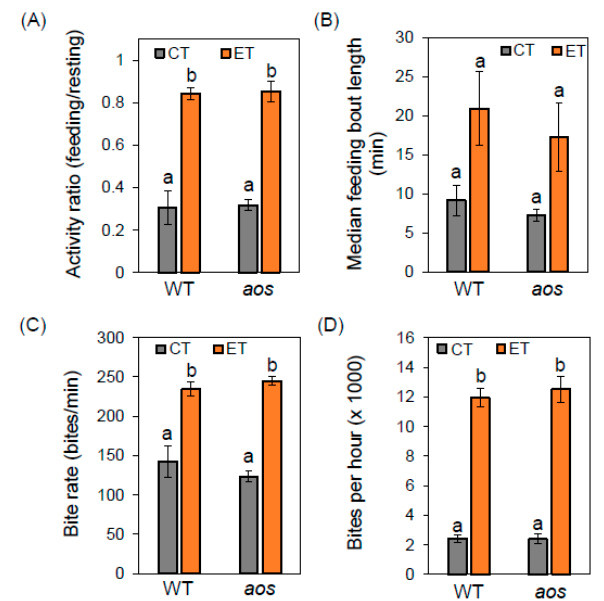
Figure 4. T. ni larvae spend more time feeding and feed faster at elevated temperature. WT and aos mutant plants were grown continuously at CT for eight weeks and then transferred to CT or ET treatment chambers. Following a 24-h acclimation period in the treatment chamber, plants were challenged with T. ni larvae that had previously been reared to the 3rd instar stage (~35 mg) on WT plants under CT conditions. Within the treatment chambers, larvae were allowed to feed for 24 h prior to monitoring of feeding behaviors by video recording for approximately seven hours. ( A ) The data show the ratio of time spent feeding to the time spent resting (i.e., not feeding) on the indicated host genotype under CT (grey bars) or ET (orange bars) conditions. ( B ) The average length of feeding bout for larvae feeding on the indicated plant genotype and temperature (CT, grey bars; ET, orange bars). ( C ) Bite rate during a feeding bout. Cameras were continuously adjusted to maintain focus on the movement of larval mandibles. Feeding rates were determined by sampling the average number of bite-motion cycles per minute. ( D ) The average number of bites per h was estimated by multiplying the average bite rate during continuous feeding (panel C) by the activity ratio estimates in panel A. The data represent the mean and SE of three biological replicates. Lowercase letters denote significant differences (Tukey’s honestly significant difference [HSD] test P < 0.05).